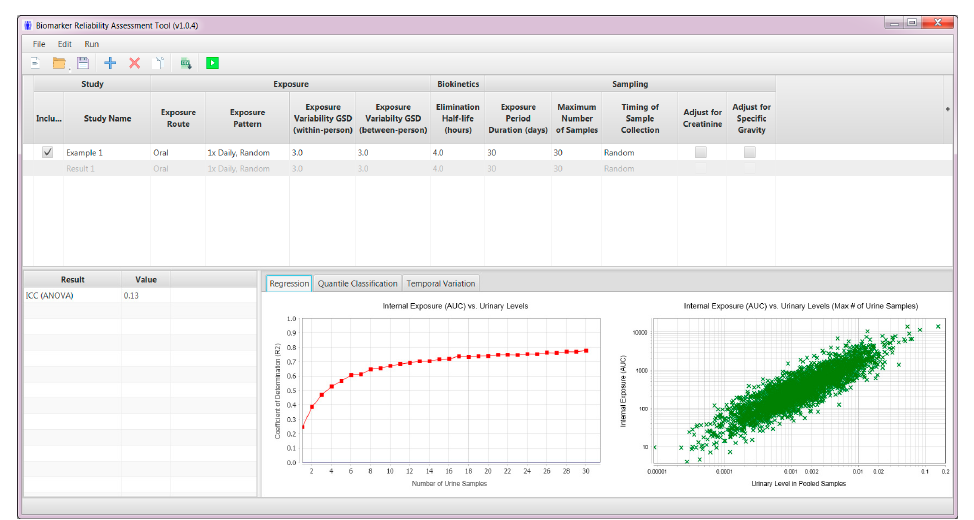
Figure 1 . Biomarker Reliability Assessment Tool (BRAT) user interface . Figure 1. Biomarker Reliability Assessment Tool (BRAT) user